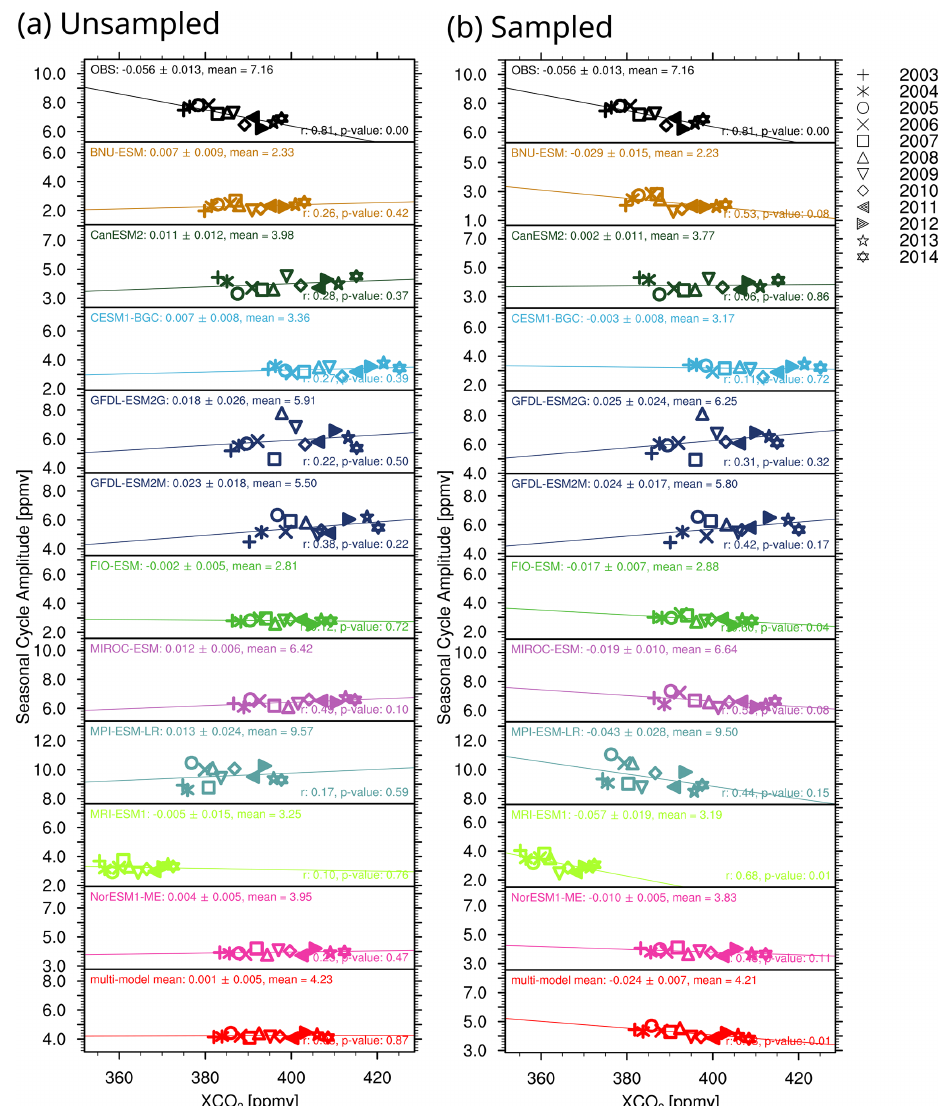
Figure B1. Same as Fig. 7 but for CMIP5 models. The left panels (a) show unsampled models, while models sampled according to the satellite data are shown on the right (b) . Note that the y -axis range is the same and only differs by a